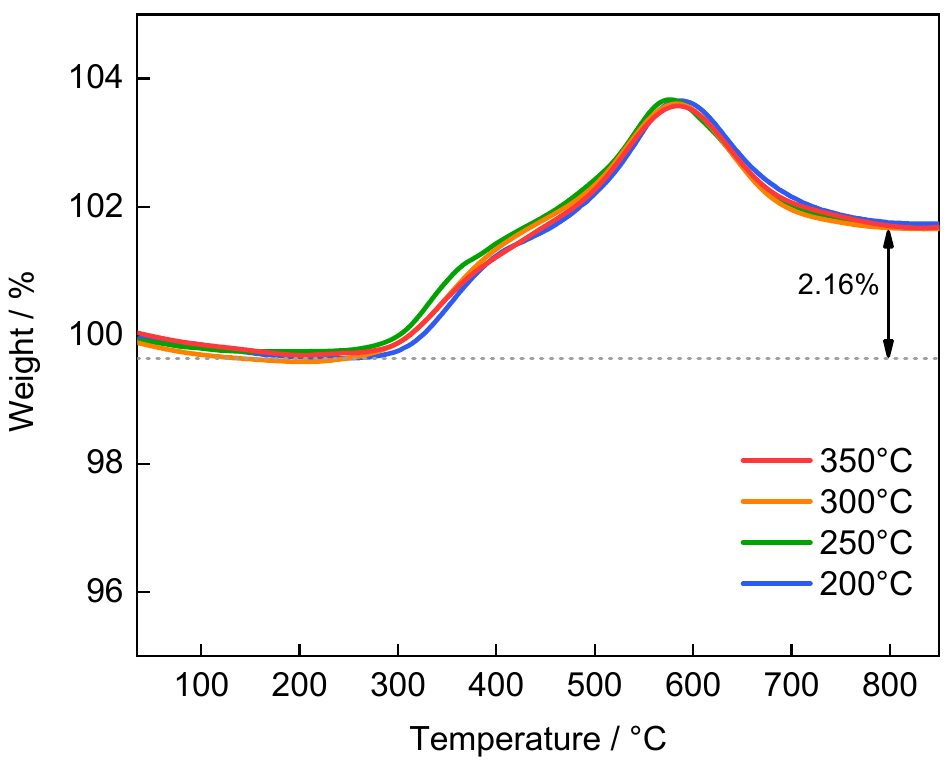
Figure 4. TGA curve of LiFePO 4 samples prepared at spray drying temperature of 200 °C, 250 °C, 300 °C and 350 °C.